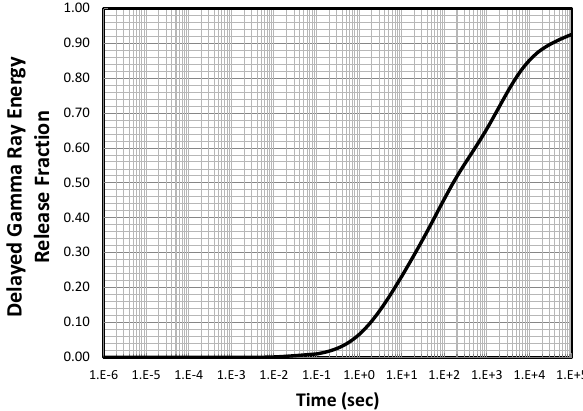
Figure 1. Time Dependent Delayed Gamma-Ray Energy Release Fraction from